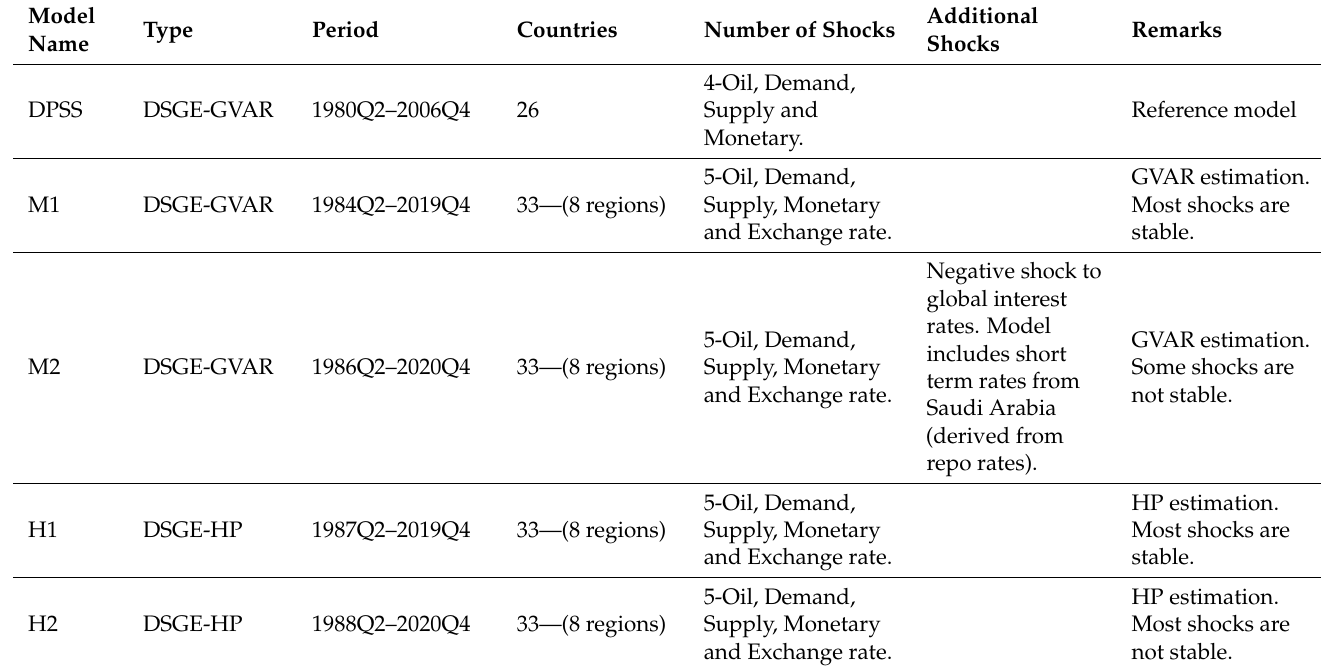
Table 2. Summary of estimated